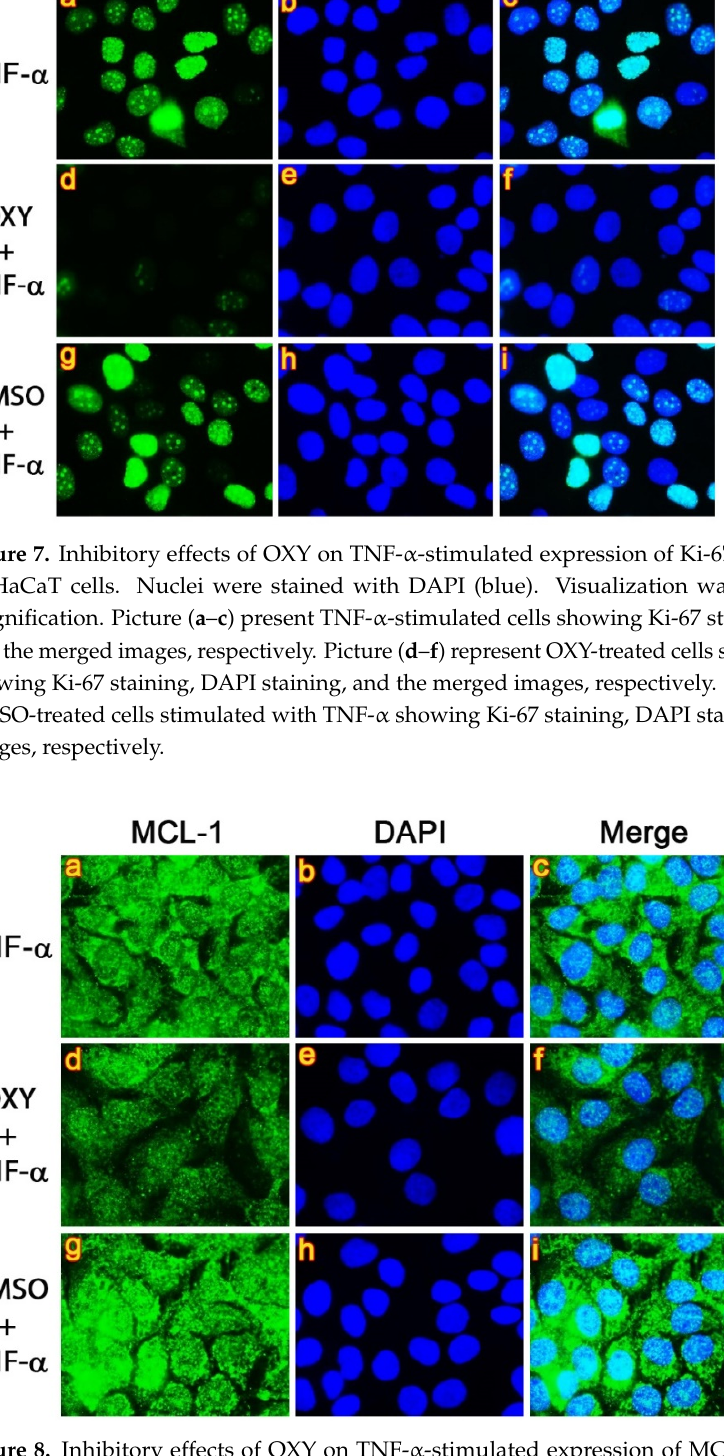
Figure 8. Inhibitory effects of OXY on TNF- α -stimulated expression of MCL-1 (green) in HaCaT cells. Nuclei were stained with DAPI (blue). Visualization was performed at 100× magnification. Picture ( a – c ) present TNF- α -stimulated cells showing MCL-1 staining, DAPI staining, and the merged images, respectively. Picture ( d – f ) represent OXY-treated cells stimulated with TNF- α showing MCL-1 staining, DAPI staining, and the merged images, respectively. Picture ( g – i ) represent DMSO-treated cells stimulated with TNF- α showing MCL-1 staining, DAPI staining, and the merged images, respectively.